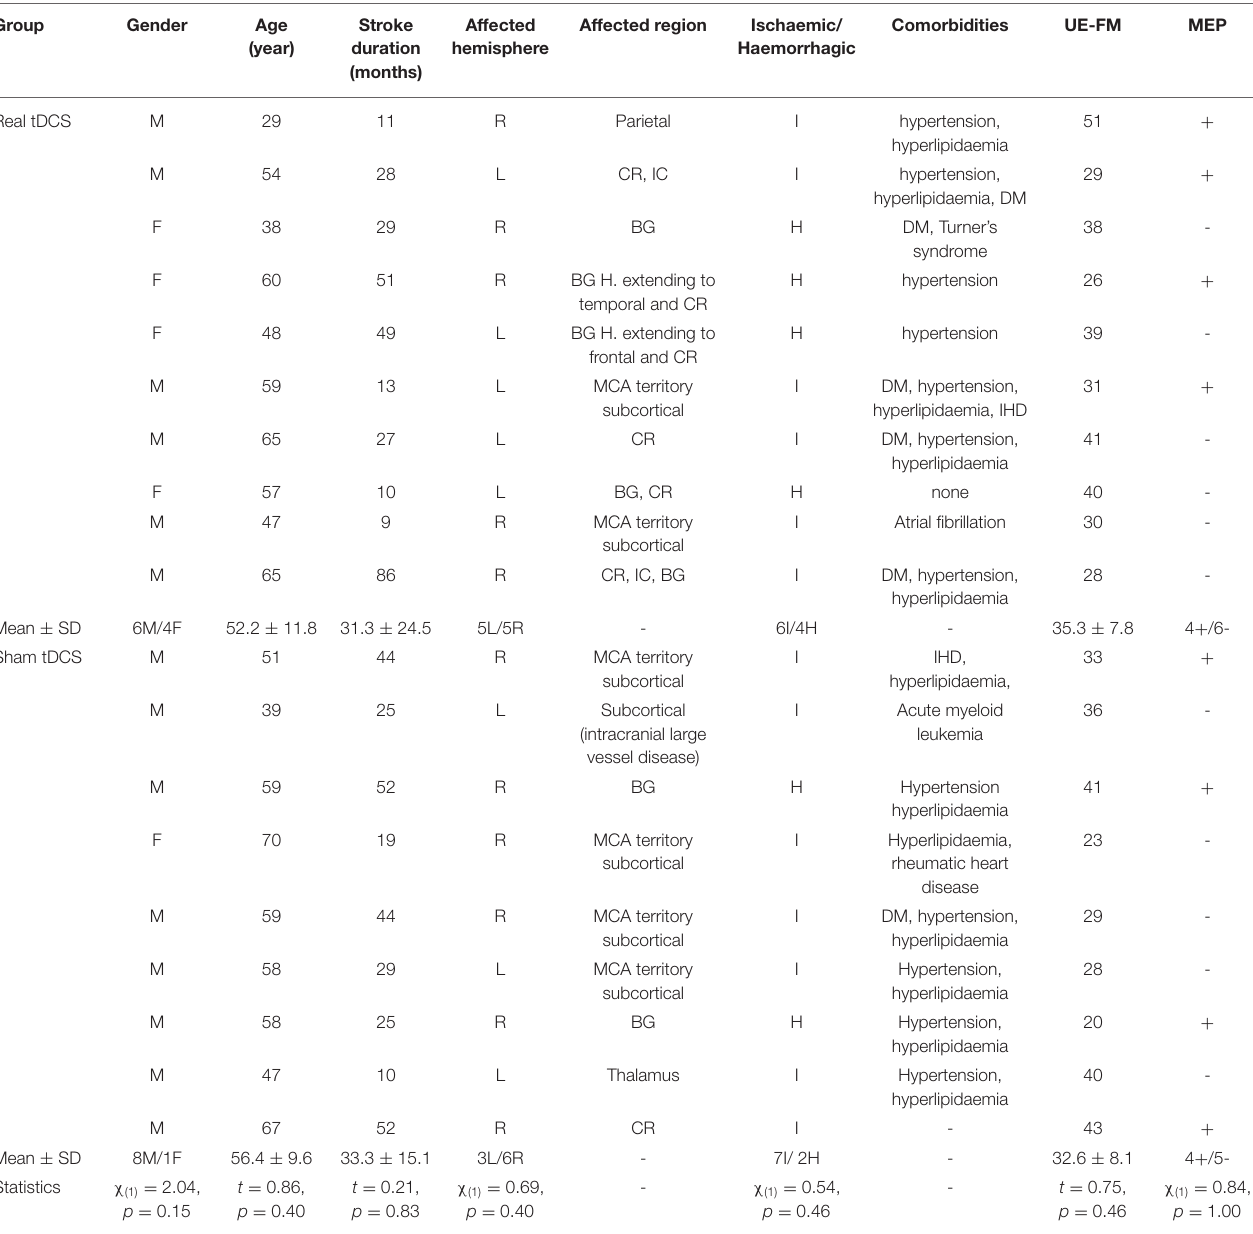
TABLE 1 | Clinical-demographics